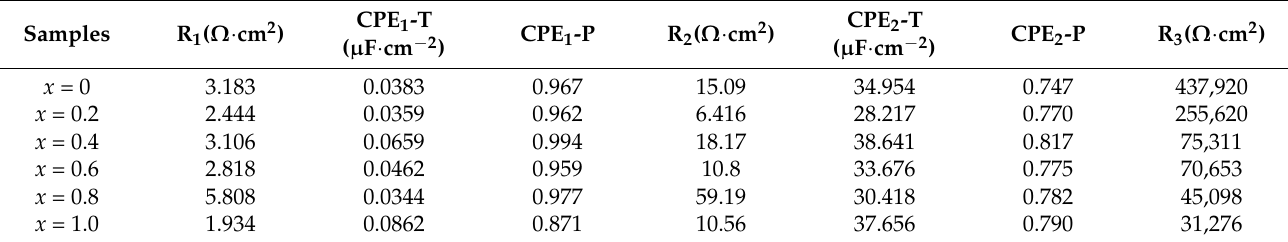
Table 2. Impedance fitting parameters of AlCrTiV 0.5 Cu x lightweight